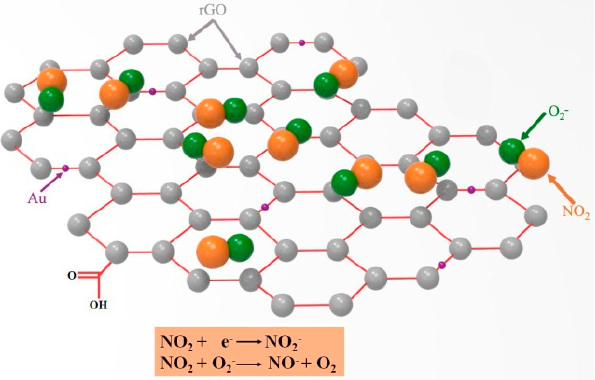
Figure 10. The scheme of the proposed gas sensing mechanism: the adsorption behavior of NO 2 molecules on the rGO/Au nanocomposite.